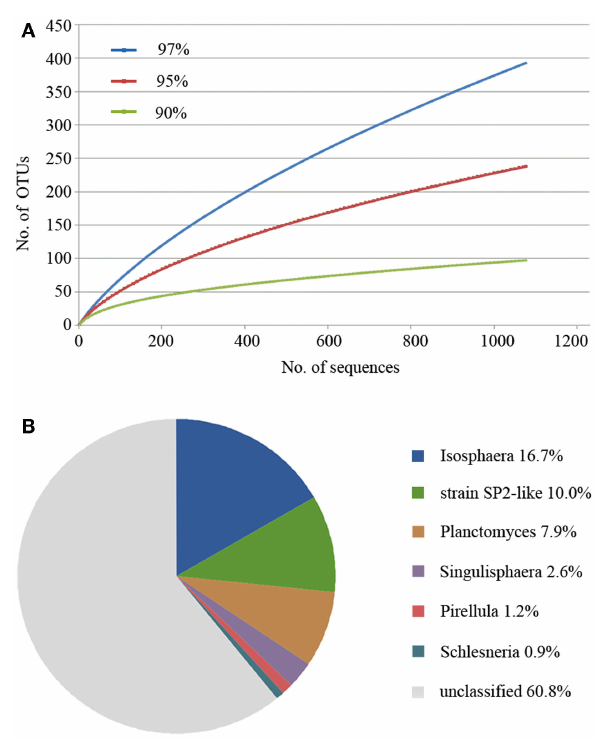
FIGURE 1 |The community composition of the Planctomycetes in an acidic peat sample as assessed by pyrosequencing-based analysis. The rarefaction curves show the relation between the retrieval of new planctomycete operational taxonomic units and the number of planctomycete sequences analyzed. Rarefaction analysis was performed at three sequence identity thresholds: 90, 95, and 97% (A) .The pie chart shows the taxonomic distribution of the planctomycete sequences retrieved from a total data set of 21189 bacterial 454 sequences (B) .